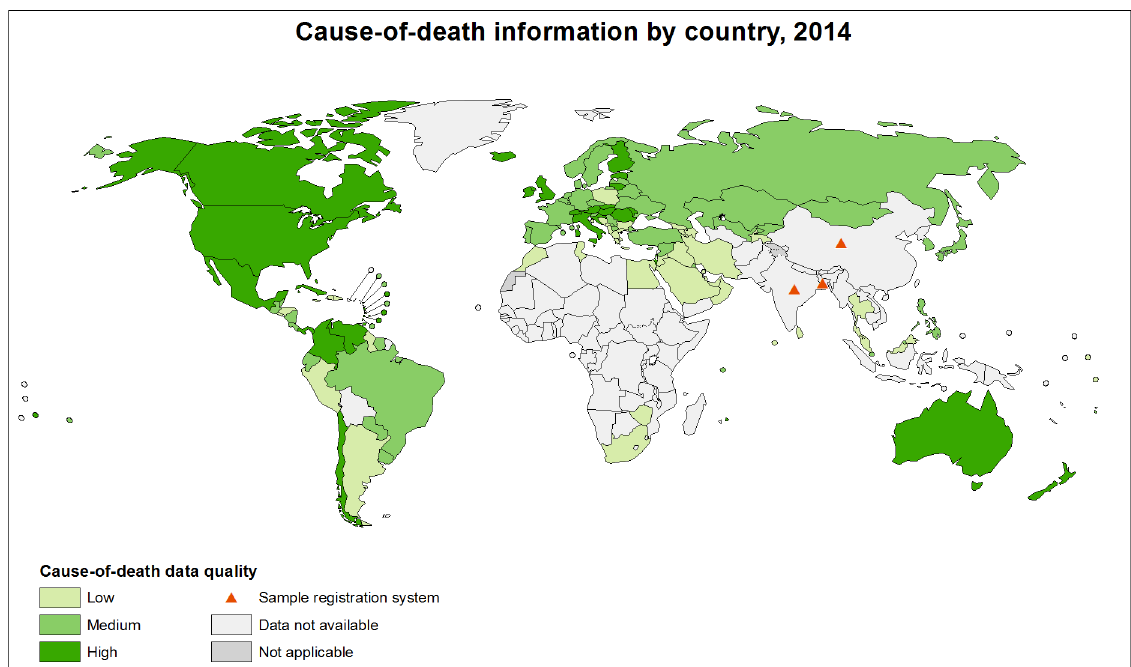
Fig 1. Cause-of-death information by country, 2014 [3]. The boundaries and names shown and the designations used on this map do not imply the expression of any opinion whatsoever on the part of the World Health Organization concerning the legal status of any country, territory, city or area or of its authorities, or concerning the delimitation of its frontiers or boundaries. Dotted and dashed lines on the map represent approximate border lines for which there may not yet be full agreement. Data Source: World Health Organization Map Production: Public Health Information and Geographic Information Systems (GIS) World Health